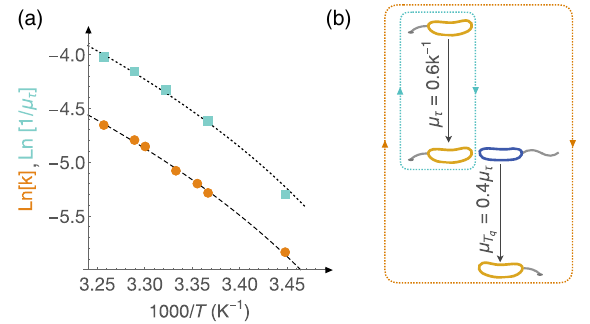
FIG. 3. Scaling of timescales in the C. crescentus life cycle. (a) The population growth rate k (orange circles) and the single- cell mean division rate from [2] (cyan squares) are shown as functions of temperature on an Arrhenius plot. The measurement precision is better than the sizes of the plot markers. The dotted (dashed) line is the best fit Ratkowsky curve [2] for the single-cell (population) data. Both fits are found to be proportional to each other, with the Ratkowsky temperature 269 K; by finding the ratio of the two curves, we find that μ τ k ¼ 0 . 6 . (b) Combining the results from (a) with Eq. (6) and results from [2], we are able to characterize all timescales in the C. crescentus life cycle as fractions of mean single-cell division time or, equivalently, the inverse of the population growth rate (see the accompanying text). At different temperatures, all timescales change propor- tionally; the proportions are shown in (b). Single-cell measure- ments sample the dynamics of stalked cell division (cyan rectangle), whereas population growth measurements sample the dynamics of stalked cell division and swarmer cell differ- entiation (orange